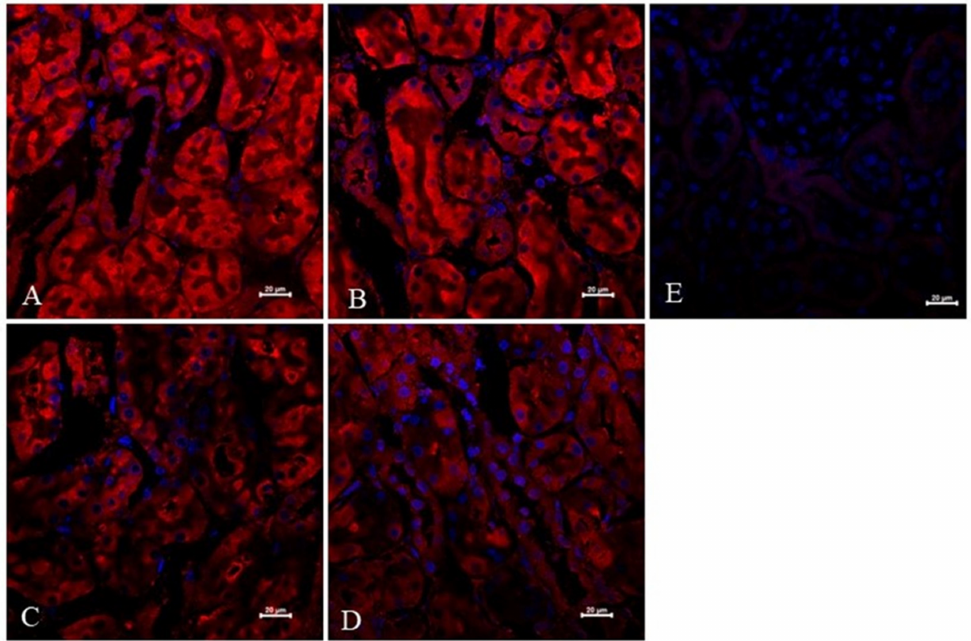
Figure 5. Immunofluorescent expression and localisation analysis of vascular endothelial growth factor A (VEGF-A) in cells of the descending limb of the loop of Henle of non-diabetic and diabetic rats treated with suramin. Suramin (SUR, 10 mg/kg) or saline (non-SUR) were injected into non- diabetic rats (CONTROL) and streptozotocin-induced diabetic rats (DIABETES) on days 0 and +7 after streptozotocin or citrate buffer injection on day –7. Immunofluorescence staining of the descending limb of Henle’s loop for VEGF-A (red) and counterstaining of cell nuclei with DAPI (blue) were anal- ysed by confocal microscopy: ( A ) non-diabetic suramin-untreated; ( B ) diabetic suramin-untreated; ( C ) non-diabetic suramin-treated; ( D ) diabetic suramin-treated; ( E ) kidney sections incubated only with the secondary antibodies (negative control); the bar corresponds to 20 µ m.